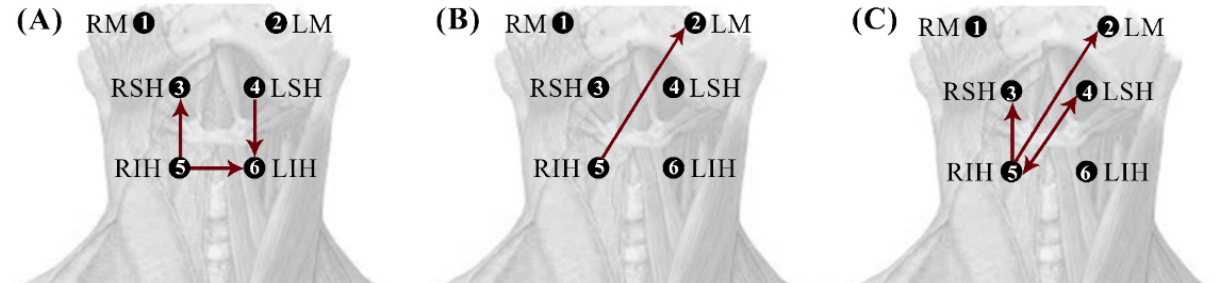
Figure 5. Schematic representations of statistically significant differences in the cG-causality of in- teraction pairs between healthy and dysphagic subjects for saliva ( A ), water ( B ), and yoghurt ( C ). Significantly higher and lower interactions in dysphagic subjects are shown in red and blue, respec- tively.